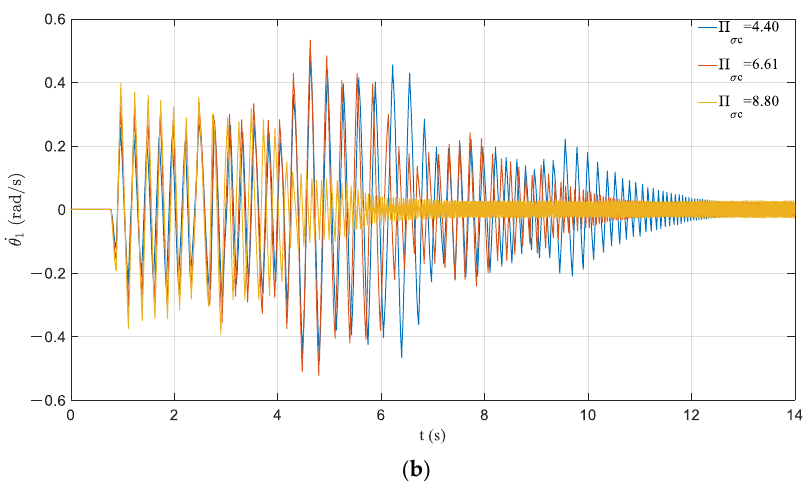
Figure 18. Effect of variation in Π σ c : ( a ) time history of rocking rotation; ( b ) time history of angular velocity.